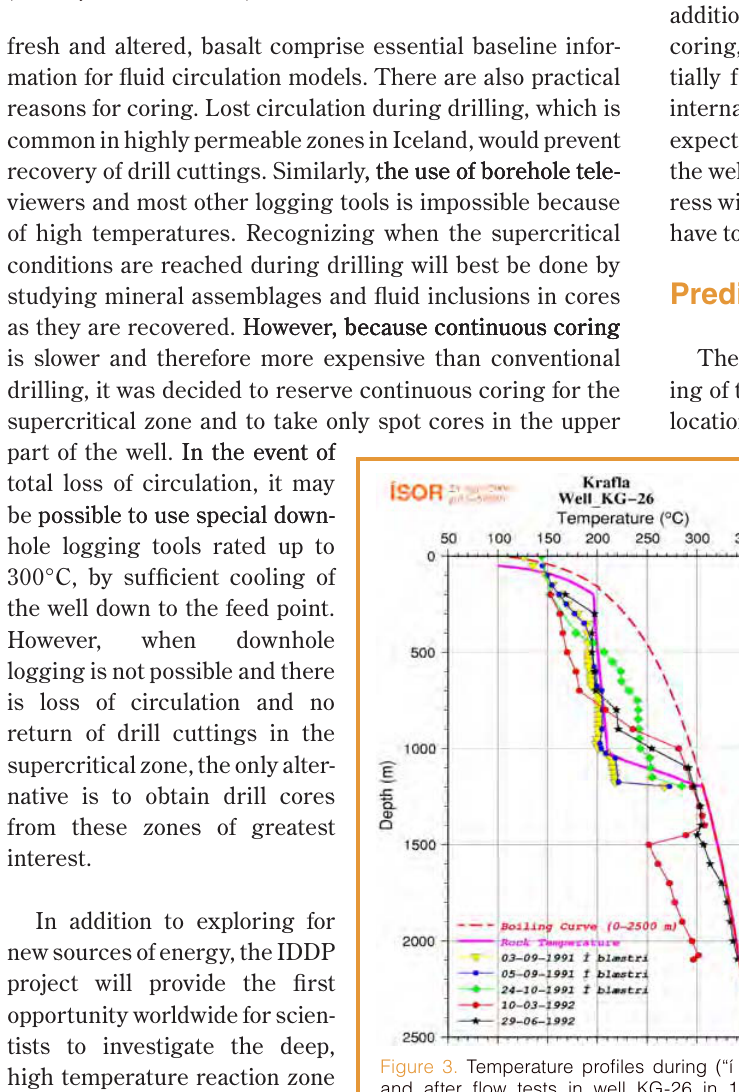
formation.Figure 2. A view to the Krafla Central Volcano. A 60 MW power plant is seen in the foreground. The red circle denotes the potential IDDP drill site (Photo by Emil Thor,